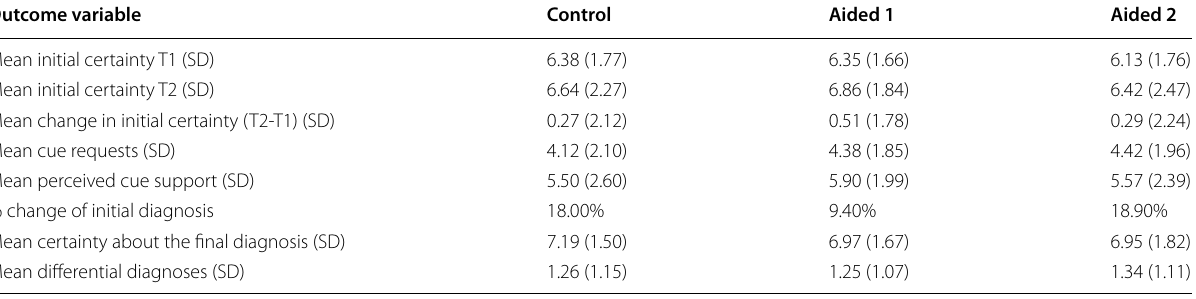
Mean change in initial certainty was positive in all conditions (increase)